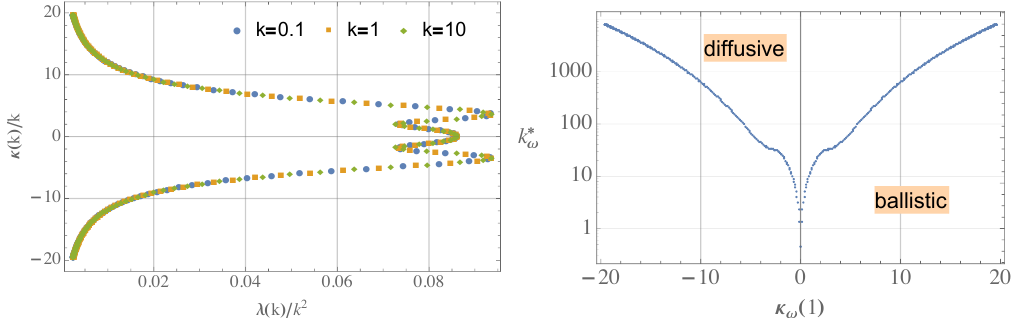
Figure 4: Left panel: We plot every third eigenvalue of D operator for k = 0.1,1,10. k In rescaled variables ( λ ( k ) / k 2 , κ ( k ) / k ) the spectral curves fall on each other exhibit- ing relation (29). Right panel: Dependence of the effective momentum k ∗ on the ω eigenstates of the D operator. We label the eigenstates by the (rescaled) imagi- k nary part of the eigenvalue z . The diffusion has a small effect for most modes and k , ω therefore the ballistic propagation dominates even for relatively large momenta. The background state is the thermal state at c = 1 and T =